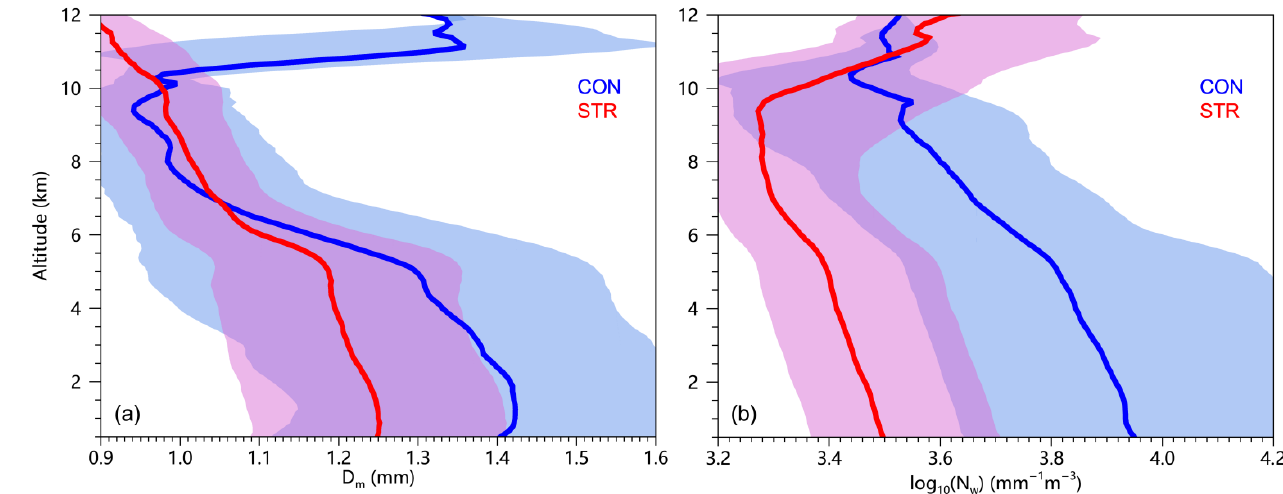
Figure 12. GPM-derived median profiles (thick lines) for ( a ) D m (mm) and ( b ) log 10 ( N w ) (mm − 1 m − 3 ) of two rain types during Typhoon In-Fa landfall. The interquartile ranges of each parameter are indicated with shaded area. The GPM observation data used here is shown in Figure 2.